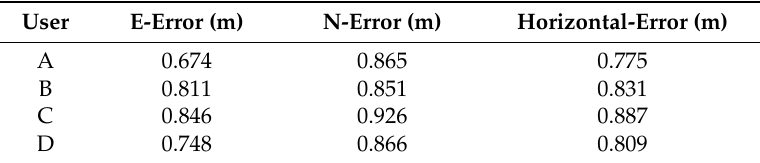
Table 8. The result of space resection for the iPhone in a real scene.